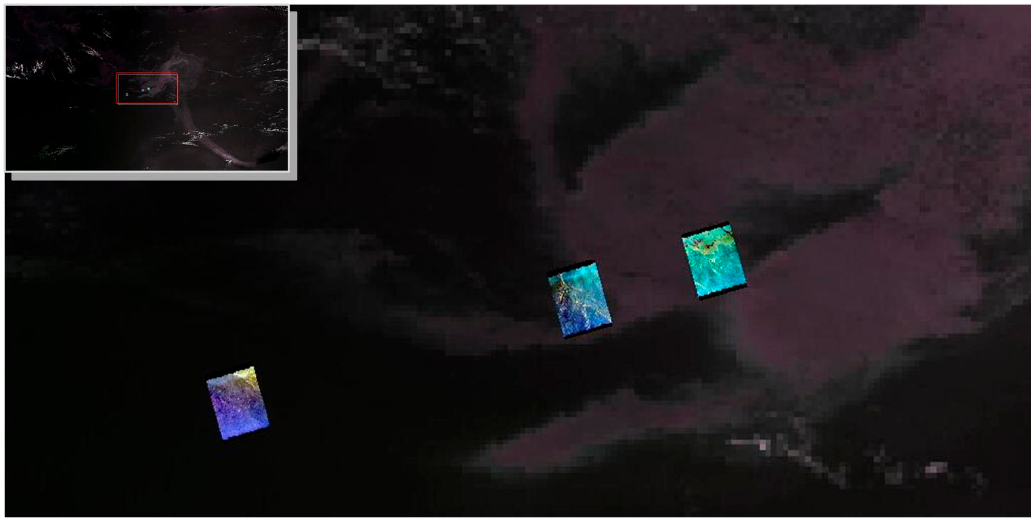
Figure 20. The identification results of this research and MODIS image captured at UTC 16:40 17 May 2010.